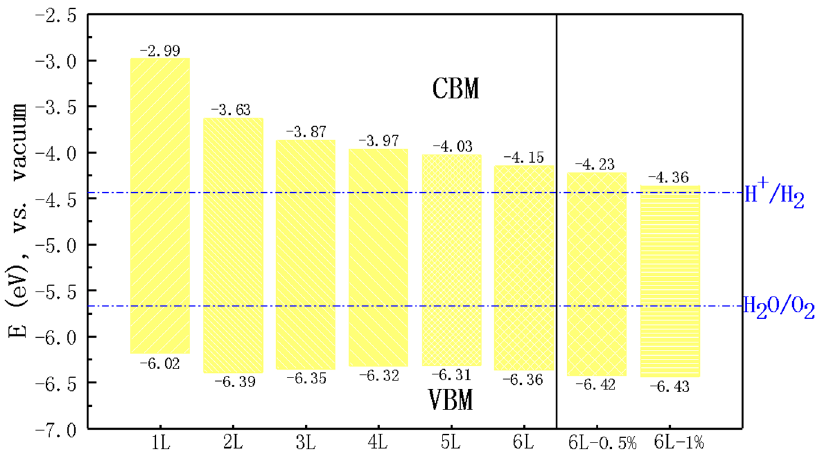
Figure 4. Band edge positions of nL ZnO (n = 1–6) and 6L ZnO under 0.5% and 1% biaxial strain relative to the vacuum level calculated using the HSE06 functional. The redox potential of water relative to the vacuum level is indicated by blue dotted lines.